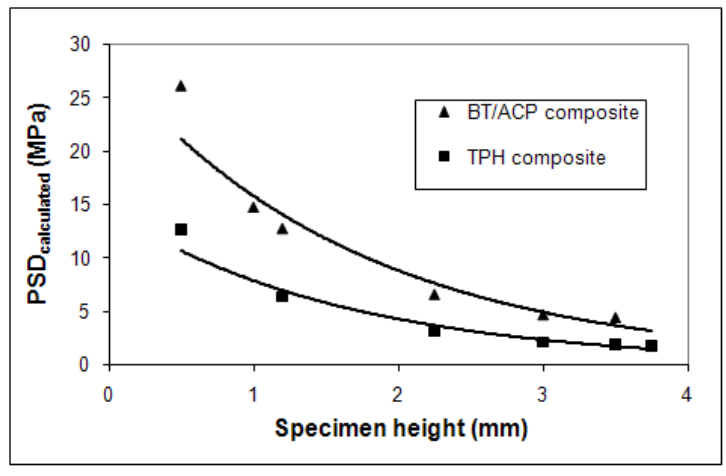
Figure 2. Functional dependence of PSD The average PSD values calculated from the mean PSD calc